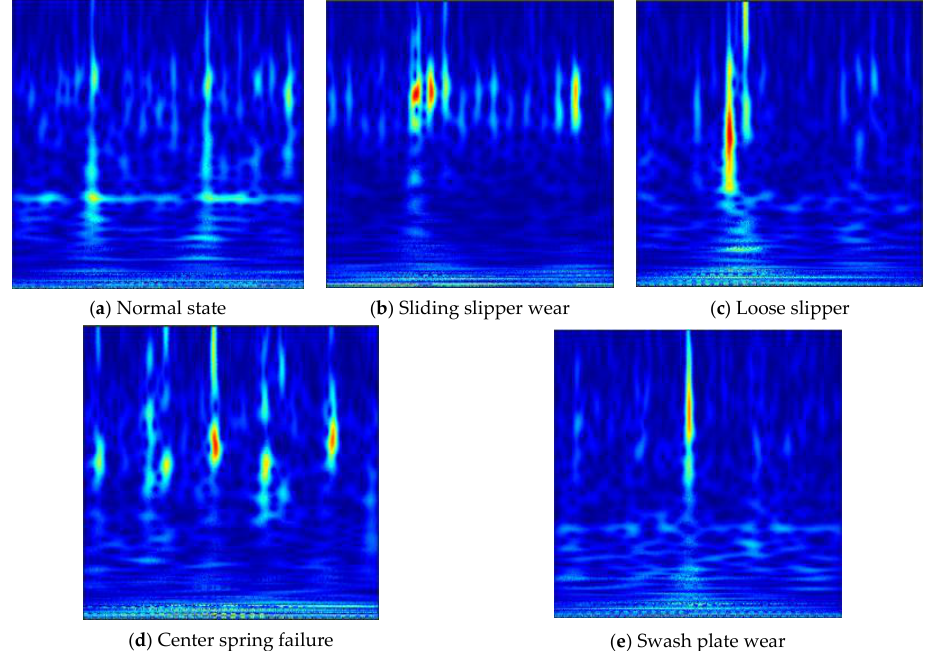
Figure 6. Time-frequency picture of five states of piston pump.